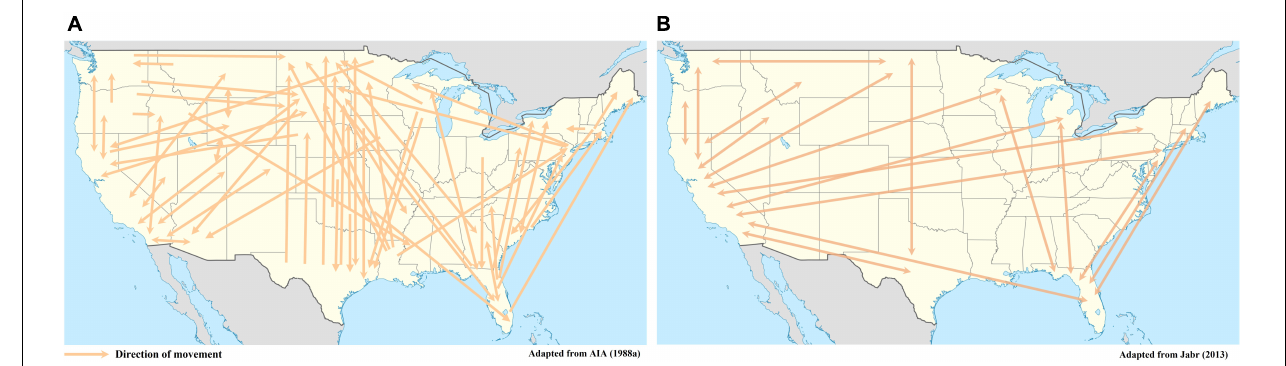
FIGURE 2 | Standard movement of honey bee colonies in migratory beekeeping operations in 1987 (A) and 2013 (B) . Map lines represent the major movement patterns of honey bee colonies, rather than smaller movements that typically occur within state or contiguous states. Significant movement begins in February (east → west), triggered by California’s almond blooming season. Following this, movement occurs mid-March to May (west → northeast) to pollinate apple, pear and cherry orchards, among other crops, and to produce clover honey. A portion of these colonies will be moved to summer locations (northeast → northern plains) to pollinate other crops. During the summer months of June and July, colonies are moved (west coast + south-central → east coast + north) to pollinate apples, cherries, cranberries and vegetables. From mid-August to mid-October, major colony movement occurs (north + northeast → south) for overwintering in warmer latitudes (Rucker et al., 2012; Jabr, 2013; VPPC, 2016; Bond et al.,